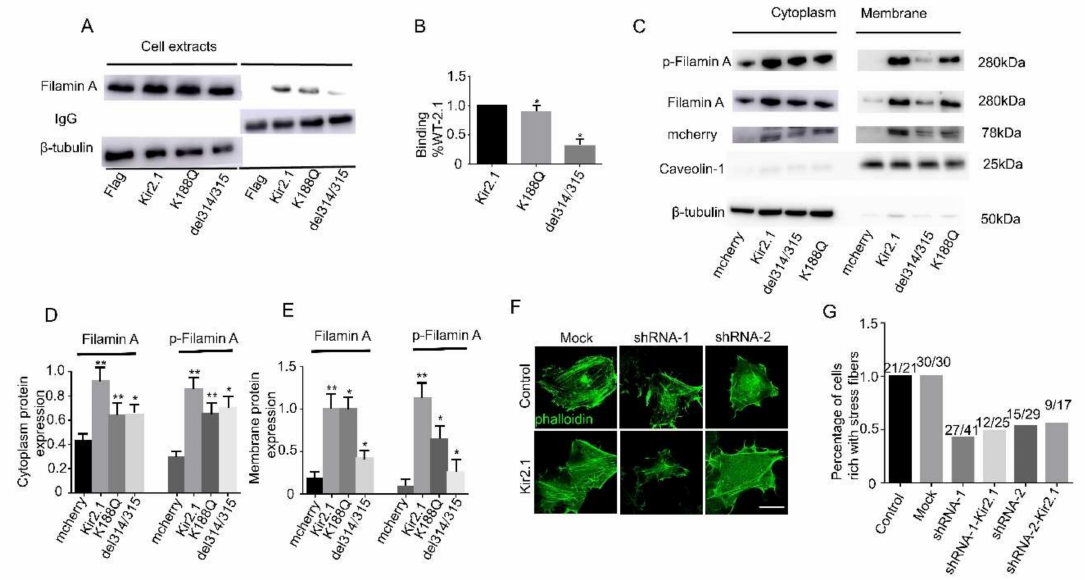
Figure 5. Kir2.1 regulates filamin A and p-filamin A redistribution. ( A ) Interaction between filamin A and Kir2.1 channels was detected by immunoblot (IB). ( B ) Quantification analysis of the binding capacity of Kir2.1 channels with filamin A. The K188Q and del314-15 mutations reduced the filamin